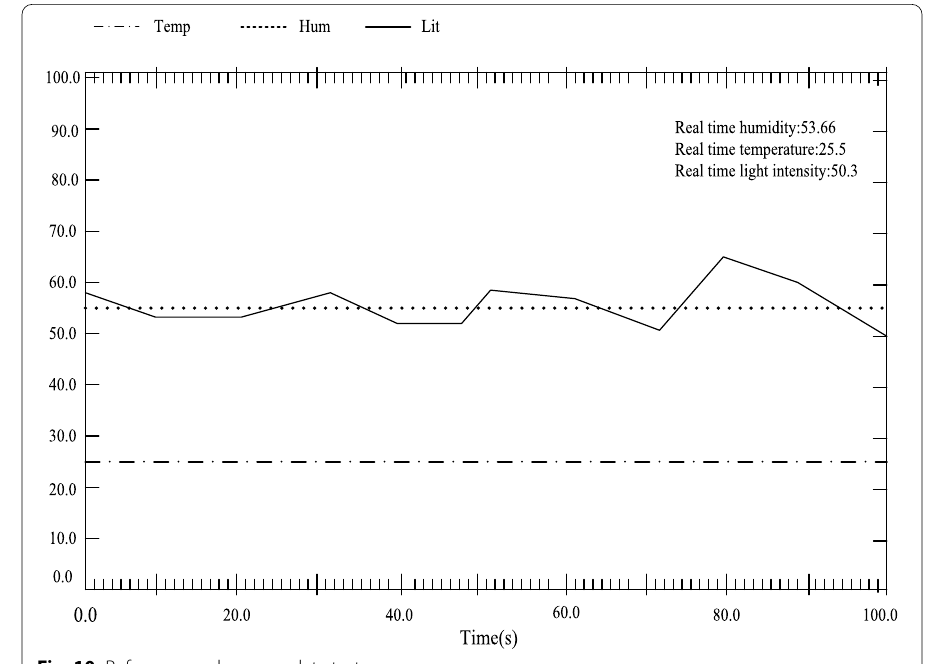
Fig. 10 Reference node sensor data test